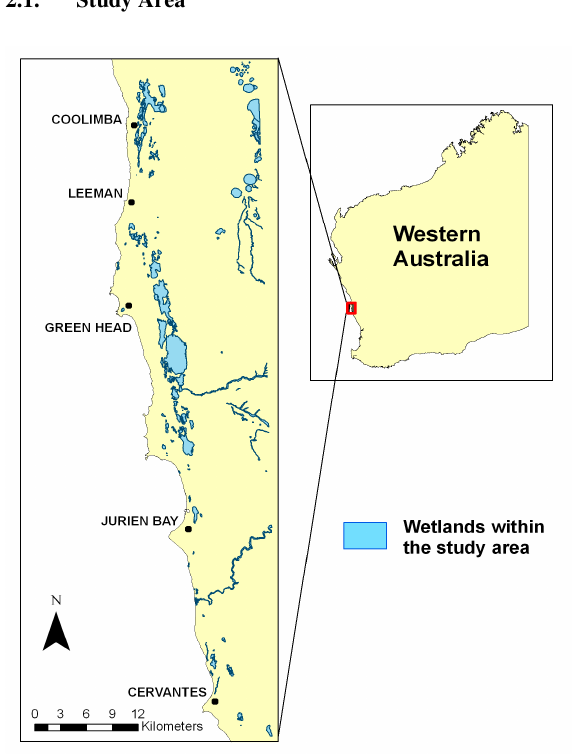
Figure 1: Cervantes to Coolimba coastal wetlands.